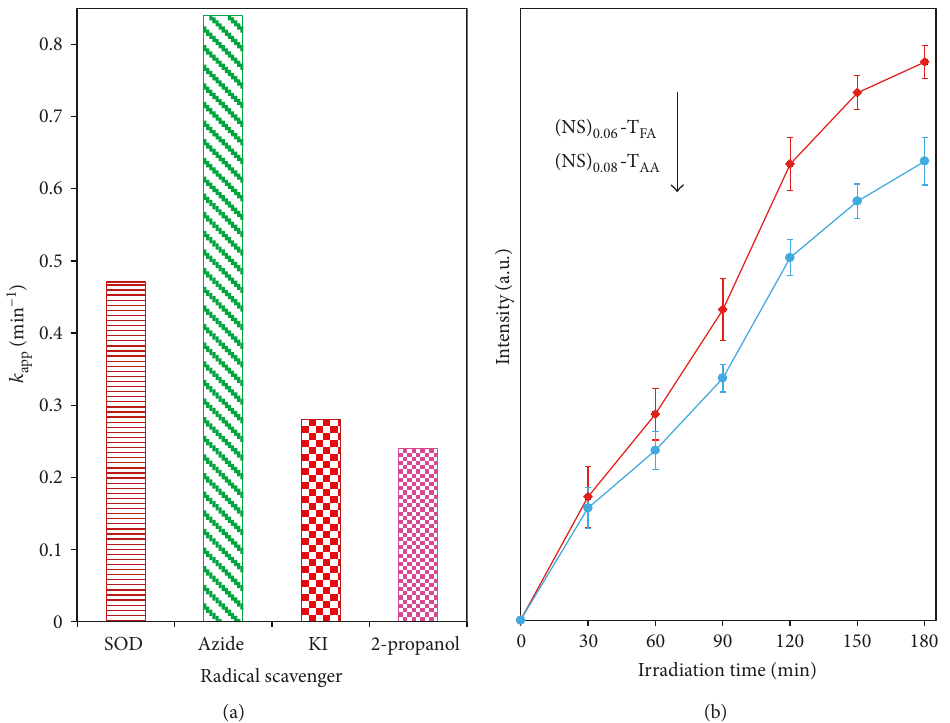
Figure 9: (a) Apparent fi rst-order constant ( k radical scavengers and (b) change in PL intensity of the highly active photocatalyst powders dispersed TA solution under UV